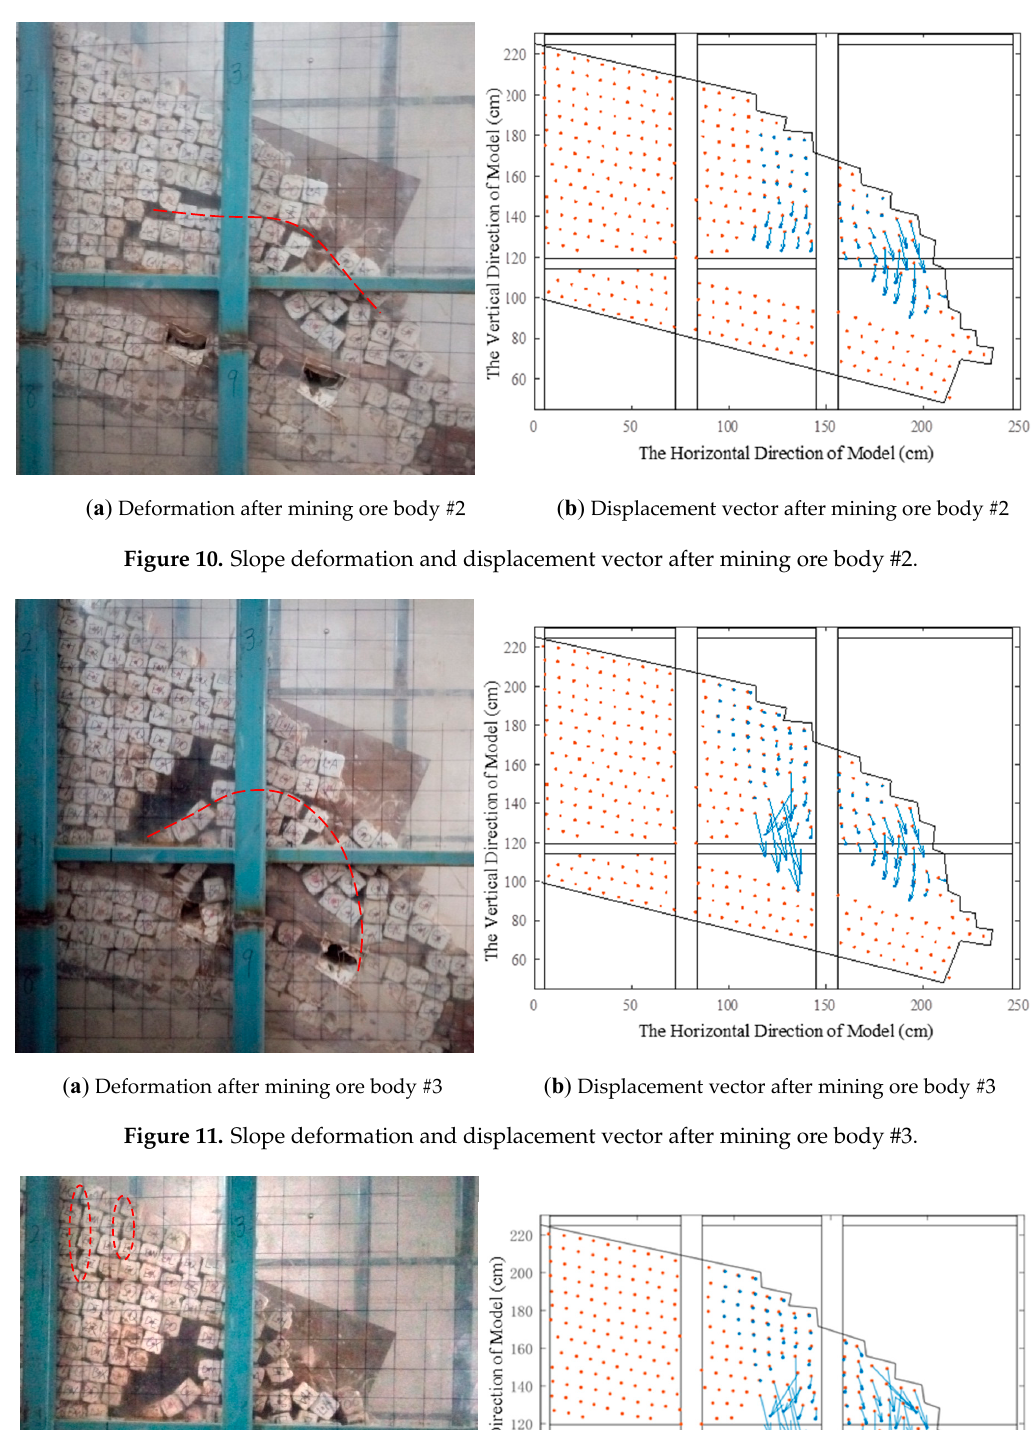
Figure 13. Front view of the model slope after four stages of mining. Subsidence pit was formed above the mining area. 6. Discussion 6.1. Comparative Analysis of Physical Modelling Result and Numerical Simulation Result Figure 14 illustrates the process of mining induced strata movement obtained by numerical simulation, which is basically consistent with the physical modelling test result. The main deformation phenomenon reappeared in numerical simulation, though the internal displacement of the rock mass is not obtained by physical modelling, the displacement obtained by numerical simulation is consistent with the displacement vector graph in the physical modelling test and can support the phenomenon of strata movement obtained by physical modelling. Displacement monitoring points are set in ten strata from the first strata directly above the mined area to the slope surface (layer 7, 8, 10, 12, 14 and 16 illustrated in Figure 7), and the horizontal spacing of these monitoring points is 15 cm. Figure 15 shows the vertical displacement of the strata directly above the mined-out area, and the displacement value is built up with the mining. The maximum